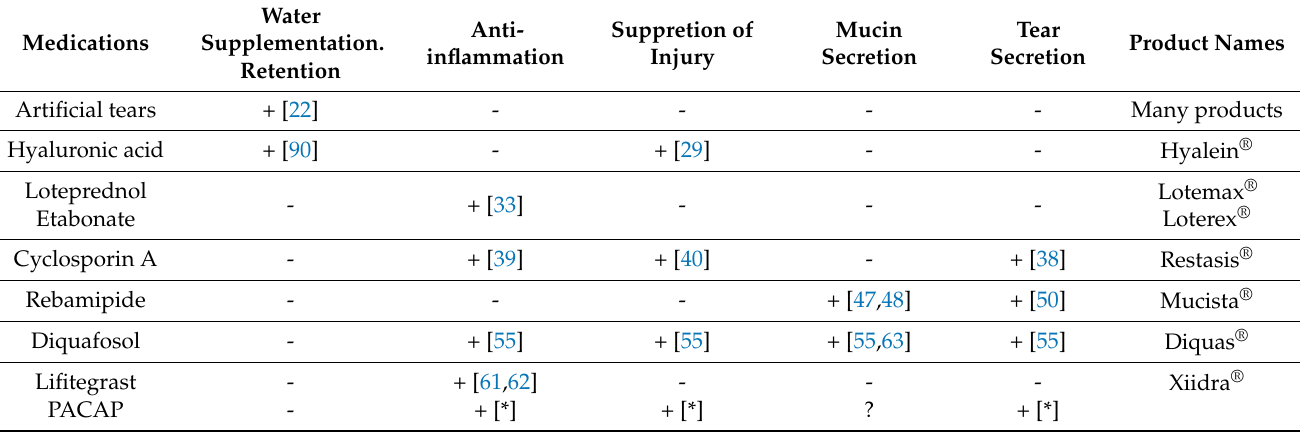
Table 1. A comparison between PACAP and commonly used DED